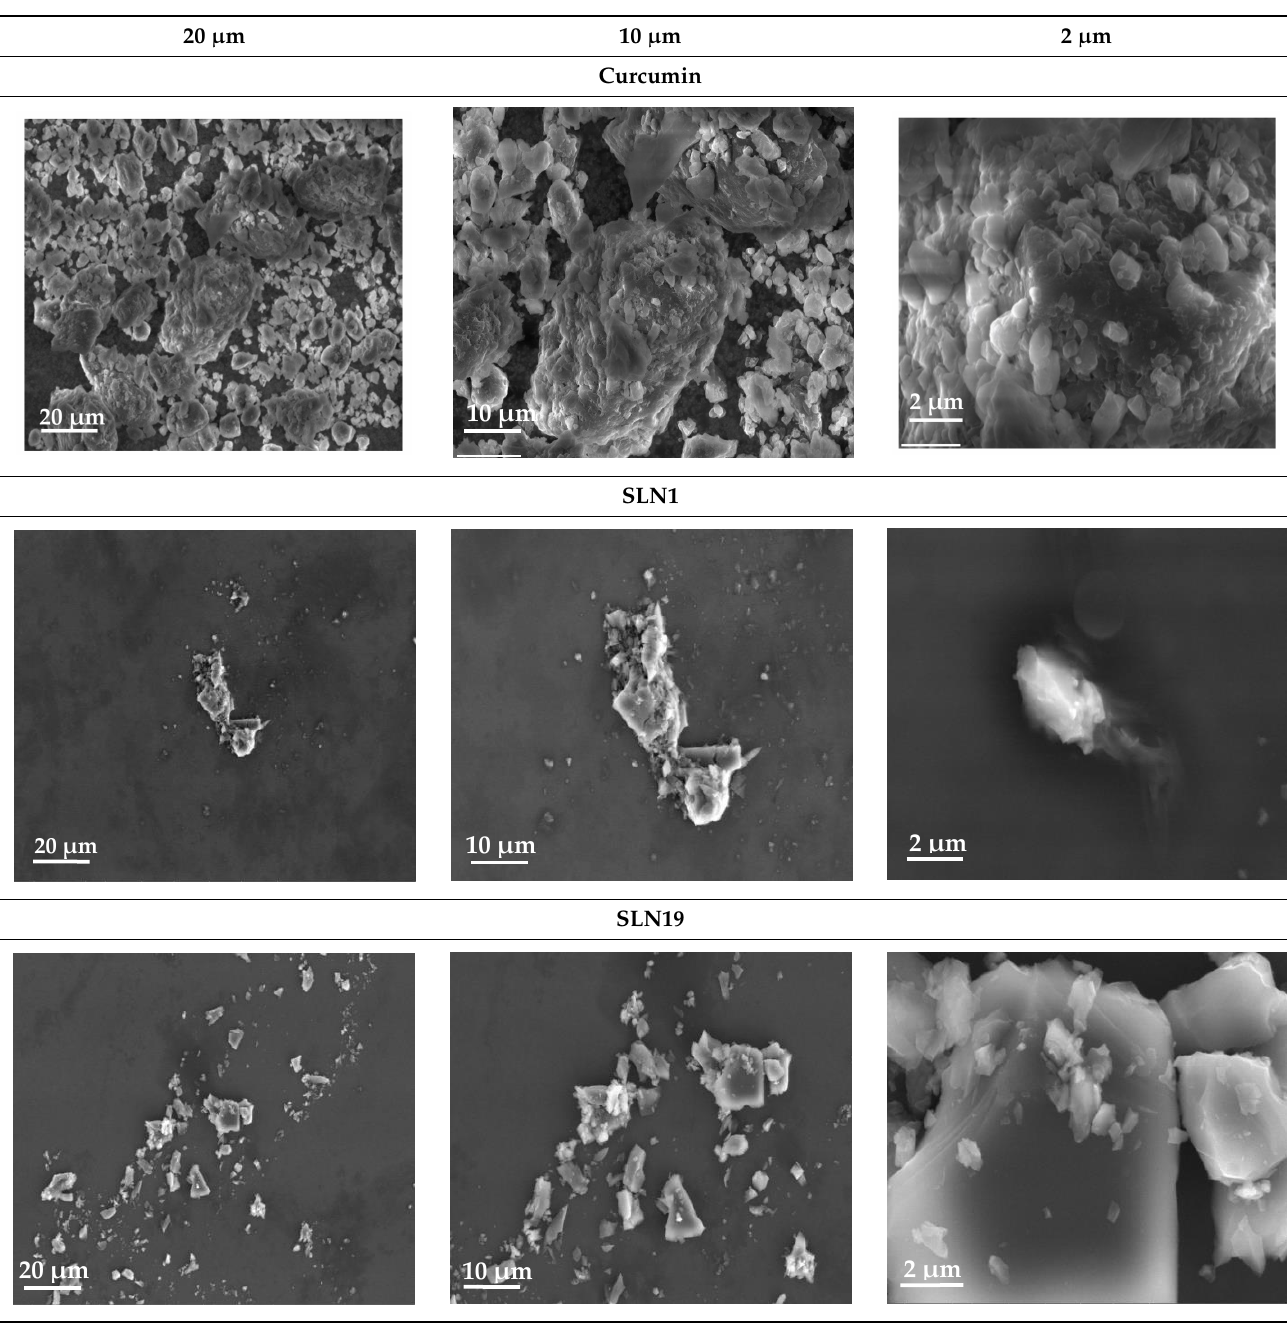
Table 3. SEM images at 20, 10 and 2 μm magnification of curcumin, SLN1 and SLN19.